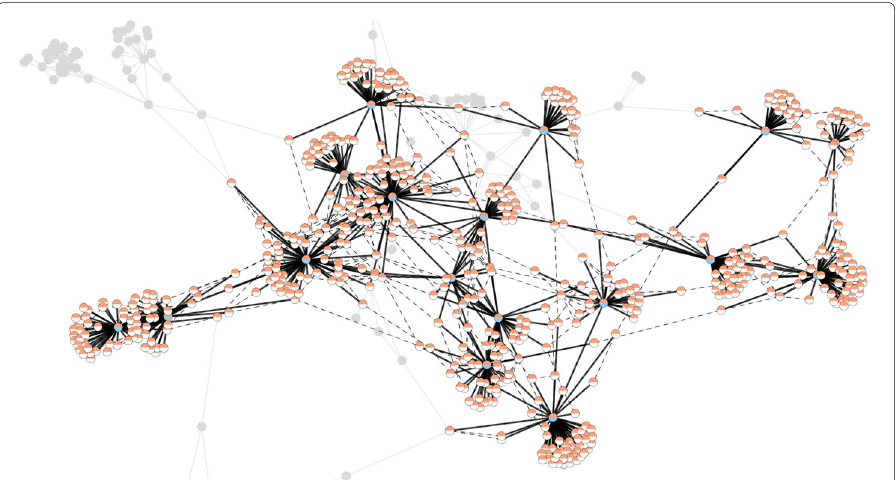
Fig. 8 The 20-Star-Sat core subgraph of the DBLP.E co-authoring Network. The 2D coordinates are computed on the whole DBLP.E network using a spring-electric display. Nodes in red are satellites surrounding 17 stars (in blue). Dashed edges relate